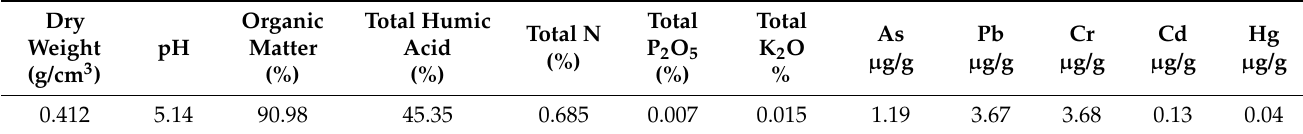
Table 1. Specific basic physical and chemical properties of woody